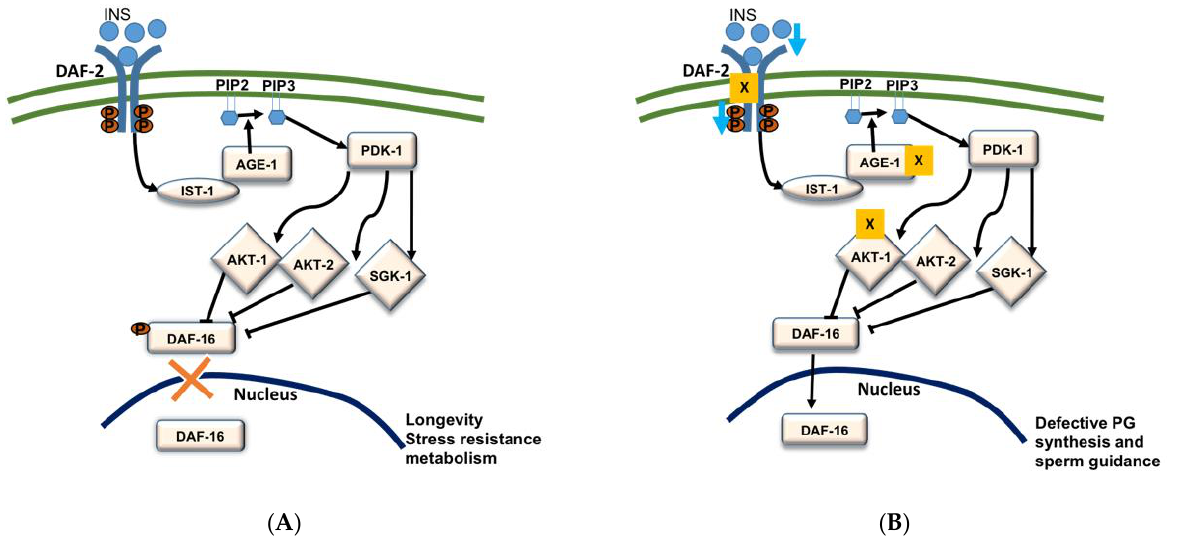
Figure 3. Schematic representation of insulin/insulin-like growth factor (IGF-1) signaling (IIS) pathway ( A ); Effects of IIS modification on PG synthesis and reproduction in C. elegans ( B ). Deletion of genes ( daf-2 , age-1 , akt-1 ) and the reduction in insulin signaling result in increased Daf-16 activity which in turn causes defective PG synthesis and sperm guidance [12].